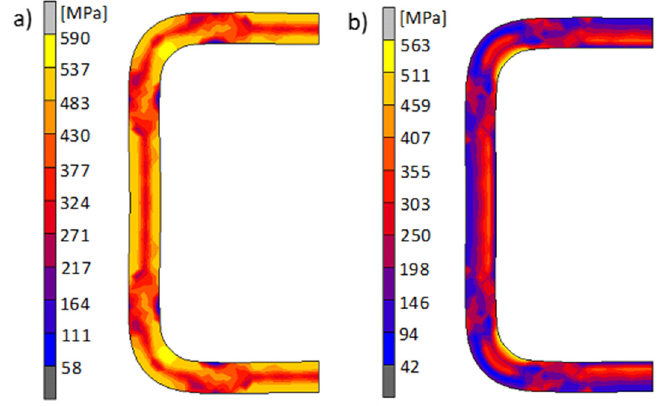
Figure 5. Distribution and values of the Huber–Mises equivalent stresses in the material of the shaped pipe: ( a ) in the final shaping phase and ( b ) after the shaping process (internal stress).